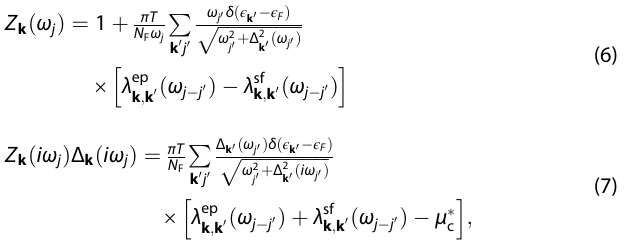
Not enough data exist to assess the trends in the superconducting gap, or in H c2 (0), but dH c2 = dT j T ! T Experimental results indicate that the CDW affects the pairing strength rather little. Note that the cited references ascribe the changes in the H c2 to the changes in the Fermi velocity, not in the order